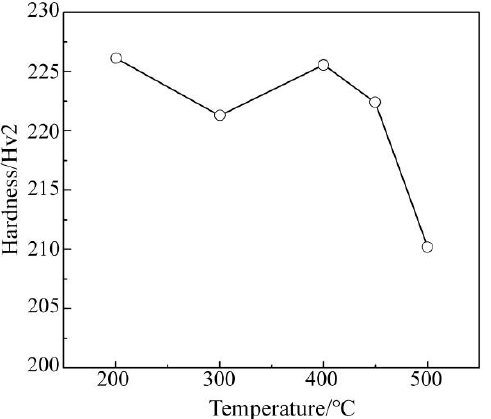
Figure 6. Hardness of the samples at different coiling